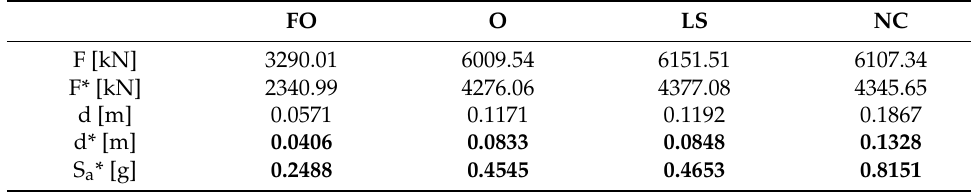
Table 7. ADRS spectrum approach (SCBF).